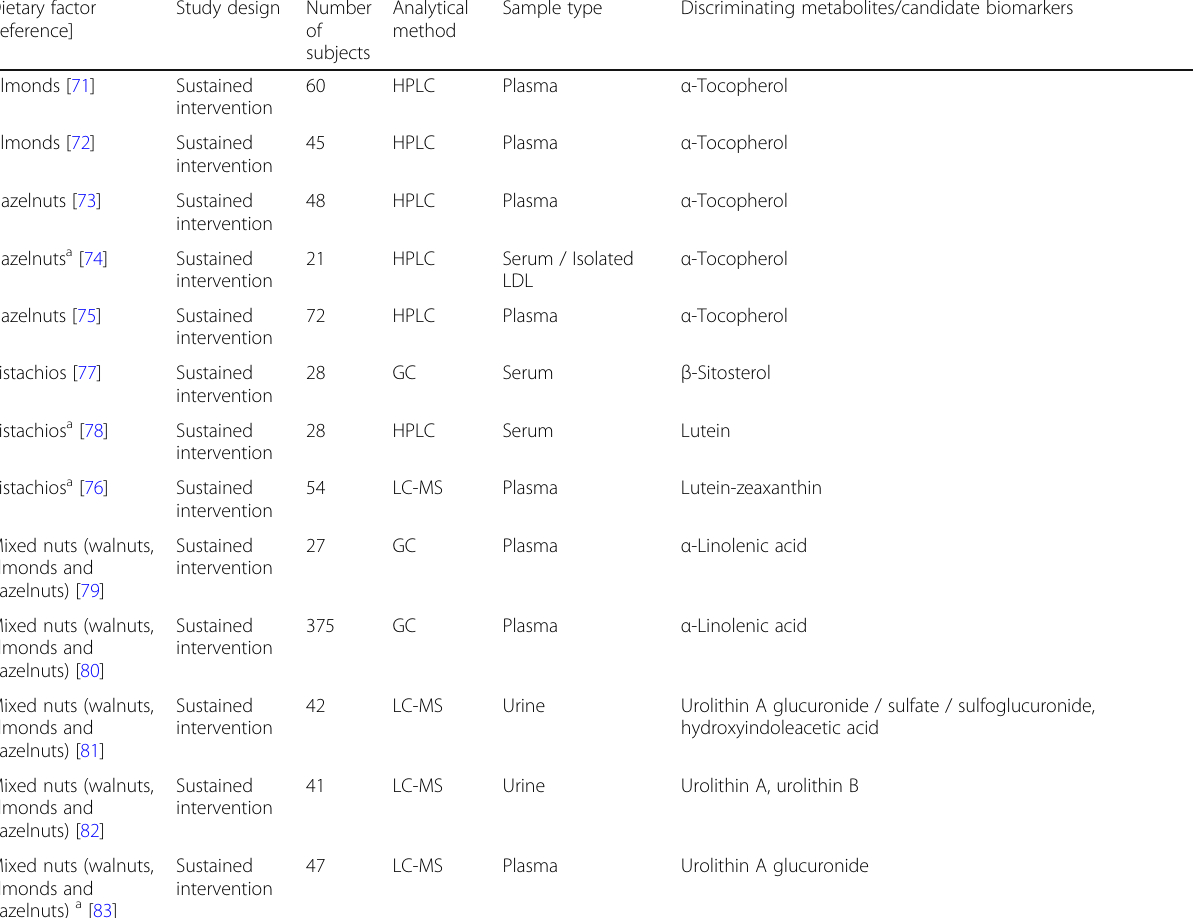
Table 1 Studies reporting associations between consumption and potential candidate food intake biomarkers for nuts (Continued) Dietary factor